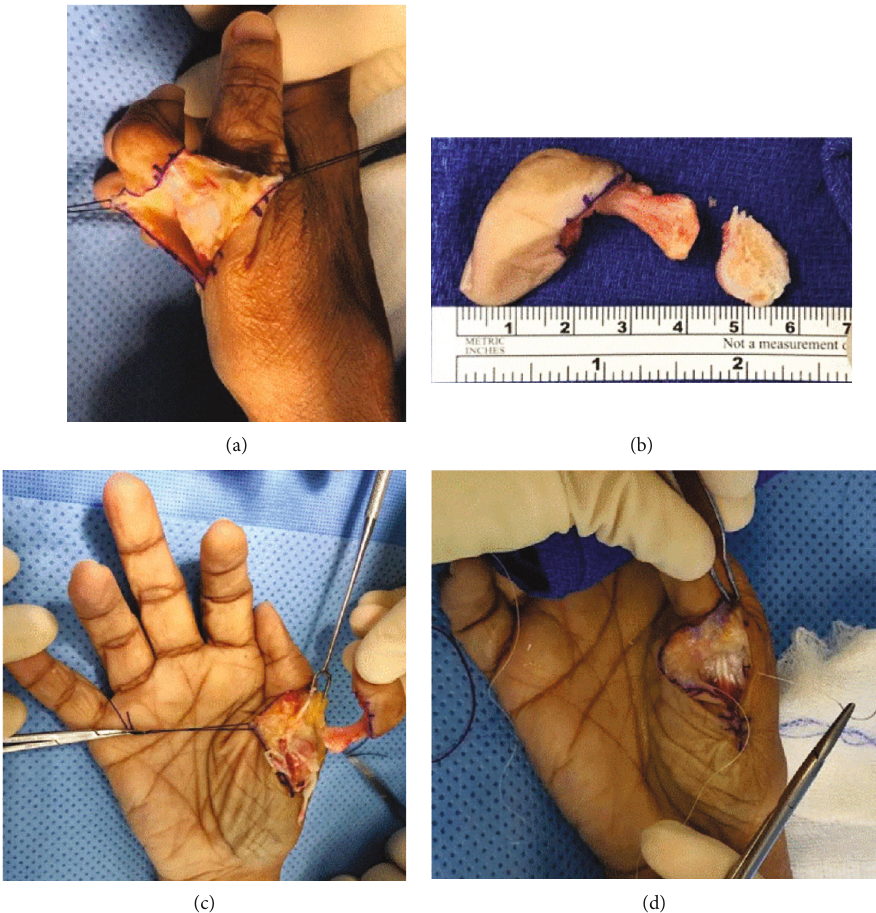
Figure 3: Intraoperative photo of procedure. (a) Thenar racquet incision made with a 15 blade around the extra digit and down the radial side at the junction between the palmar and dorsal skin. (b) Disarticulated extra digit, measuring approximately 6cm, excised after the extensor and fl exor tendons were sharply released distally. (c) Radial facet of the radial thumb joint needing to be removed. Residual capsule was elevated o ff of the metacarpal base (origin of RCL), and a saw was then used to remove the articular surface and dorsal osteophyte. (d) Approximation of the tendinous insertion of the thenar musculature onto the dorsoradial capsule of the residual proximal phalanx using 3-0